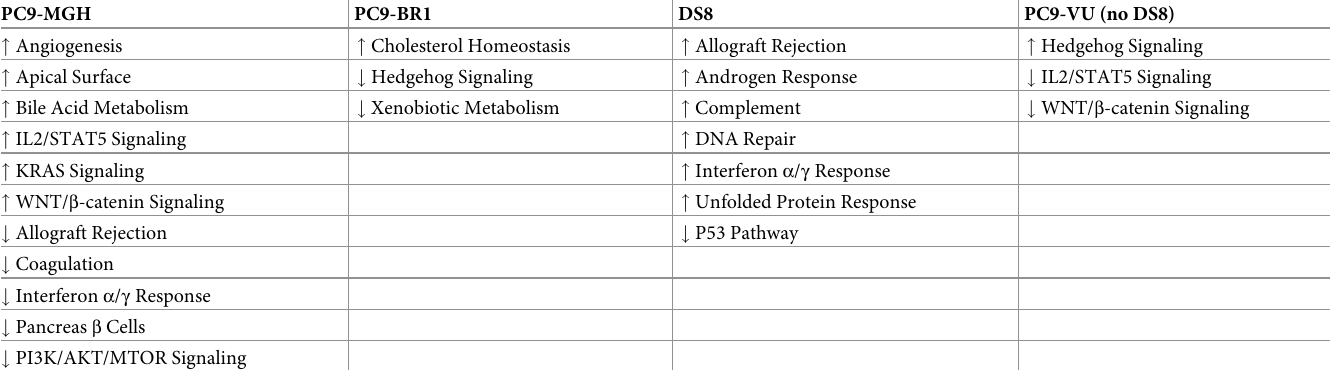
Table 1. Simplified representation of hallmark gene signature scores across different members of the PC9 cell line family. Single-cell transcriptomics data from all 8 PC9 cell line family members were subjected to a VISION functional interpretation analysis to calculate scores for single cells from 50 MSigDB hallmark gene signatures. Distributions of scores were calculated for each cell line family member-gene signature pair. Signature score distributions that show larger ( " ) or smaller ( # ) values com- pared to other cell line family members are noted. Cell line family members with the largest transcriptomic differences (PC9-MGH, PC9-BR1, DS8, and PC9-VU) were chosen for comparisons. “PC9-VU (no DS8)” includes the parental PC9-VU and DS3, DS6, DS7, and DS9 subline distributions, since they all have a large degree of tran- scriptomic